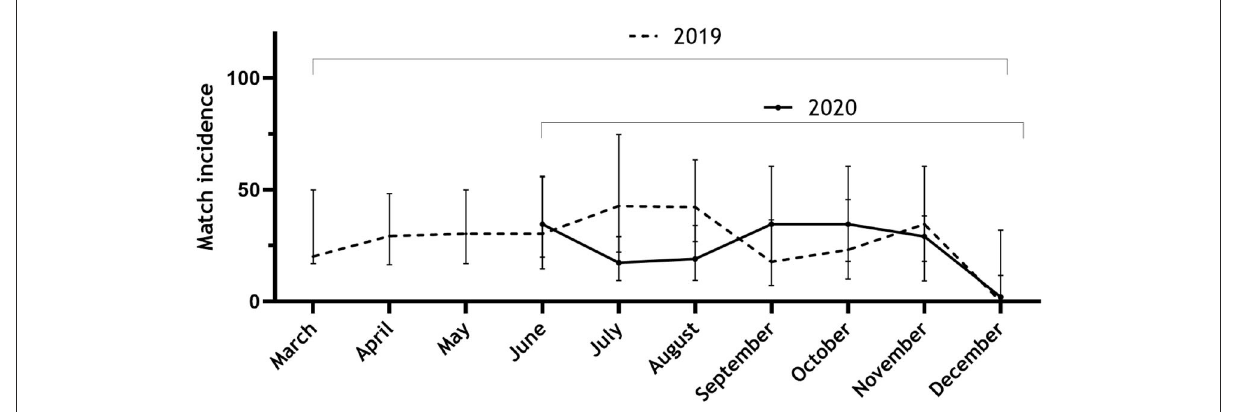
FIGURE3 Timeline of monthly match injury incidence across the 2019 and the 2020 seasons.